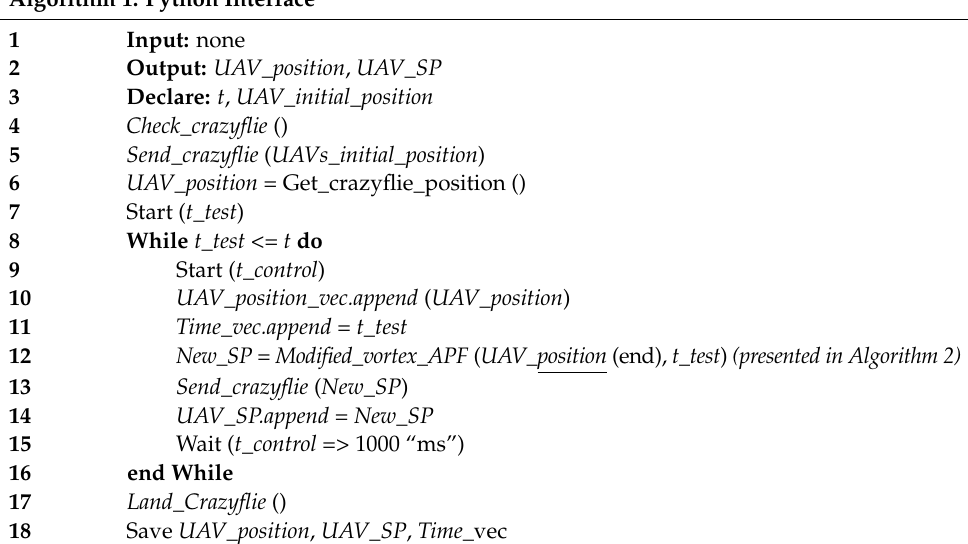
Algorithm 1: Python